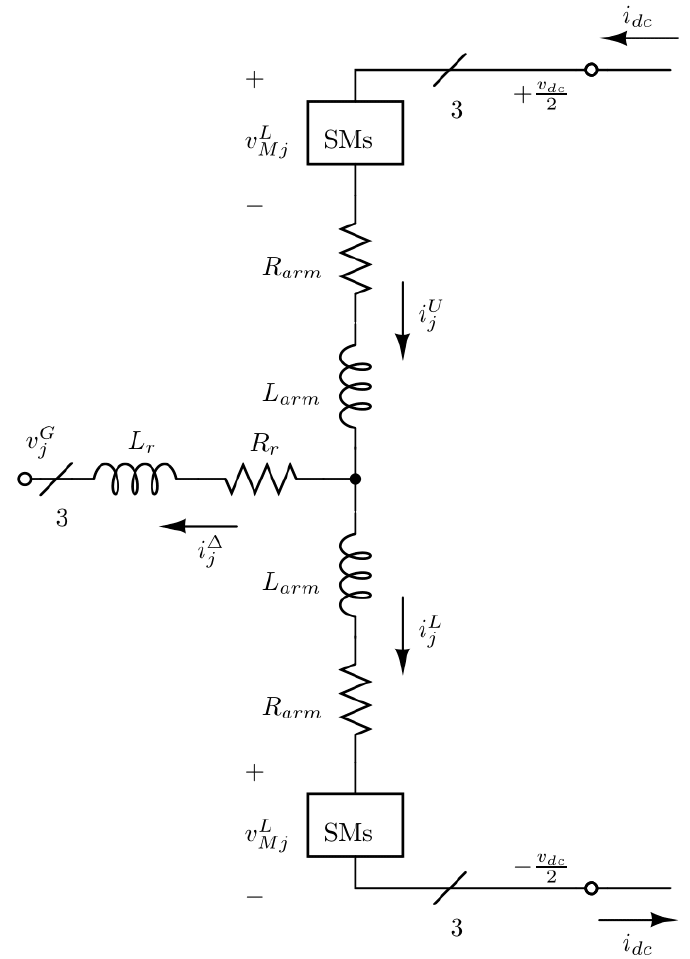
Figure 2. Modular Multilevel Converter (MMC)